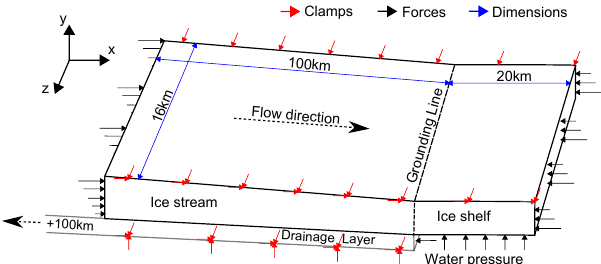
Figure 2. 3-D model domain, showing the boundary forces (black arrows) and flow constraints (red arrows). The subglacial drainage system extends a further 100km upstream from the ice-stream boundary. Note that since the problem is symmetrical, the medial line is considered to be the plane z = 0 and the ice stream being modelled is therefore 32km wide. The term clamp is used to denote a node that cannot move in one or several degrees of freedom as indicated by the direction of the